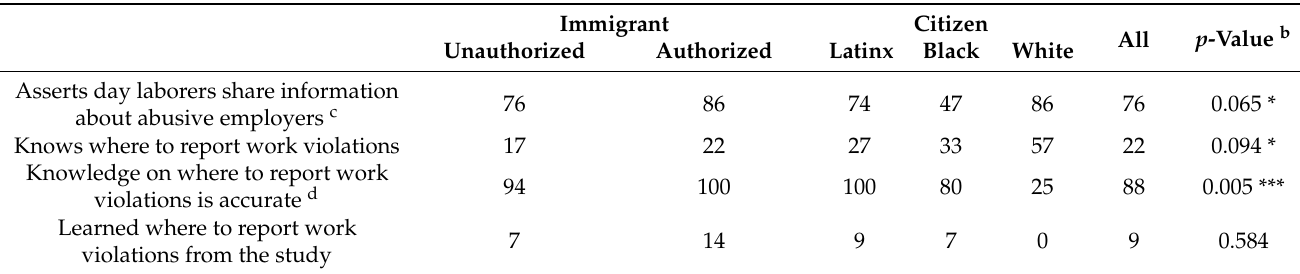
Table 6. Resistance mechanisms a